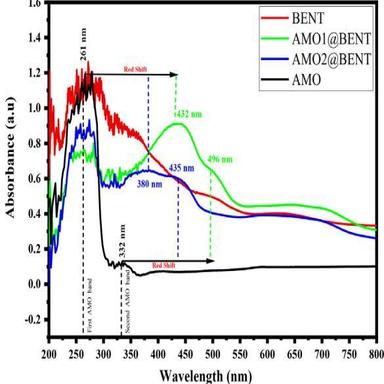
UV-Vis spectra of AMO, BENT, AMO1@BENT and AMO2@BENT materials.